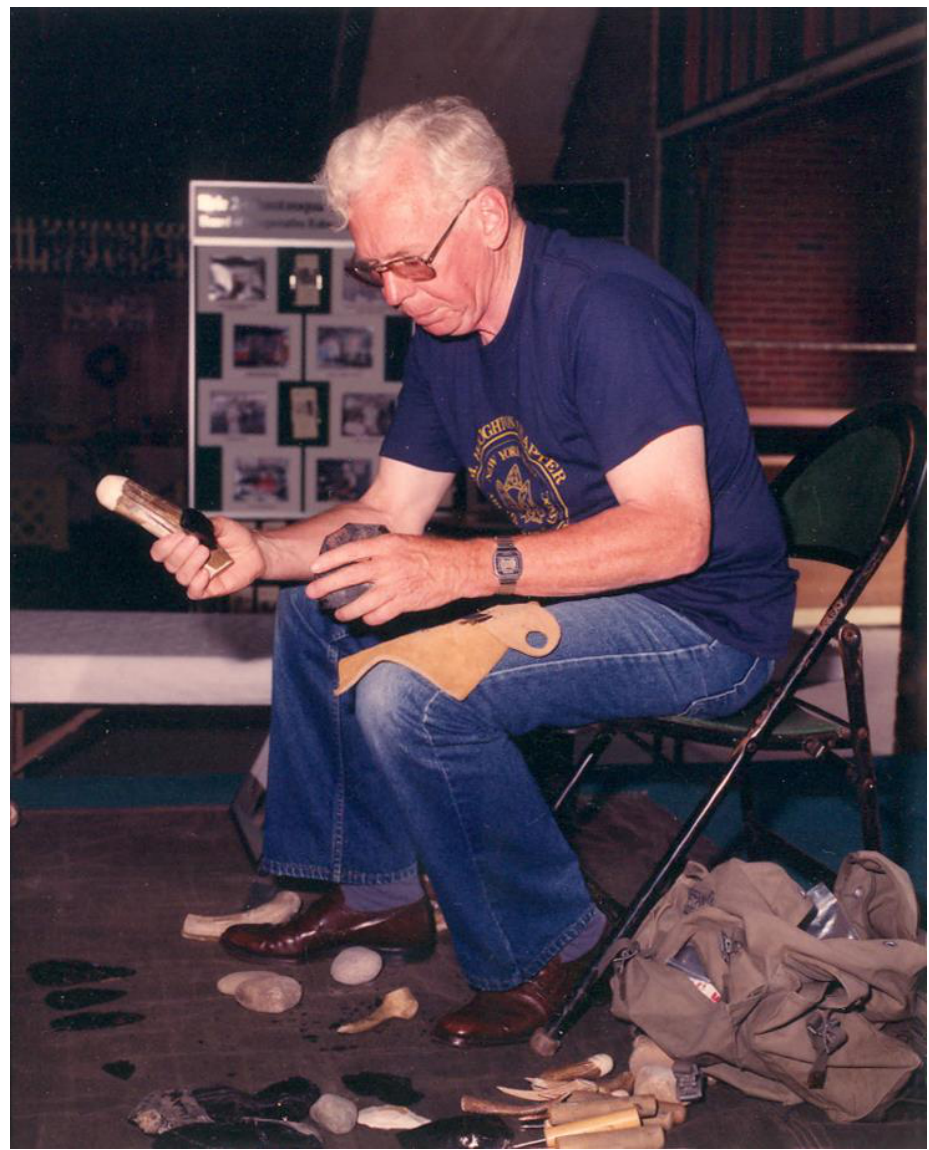
Figure 2. Jack Holland demonstrating knapping techniques. (Photo by Jack